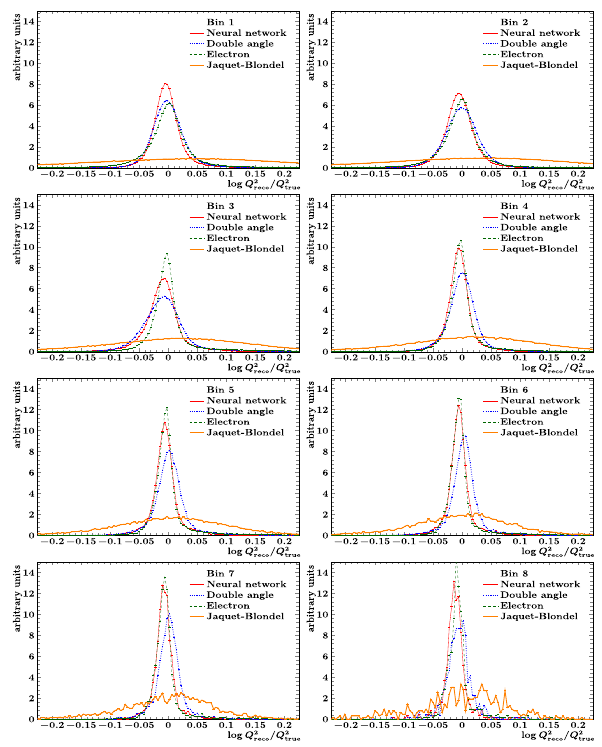
/ 1GeV 2 forvarious true